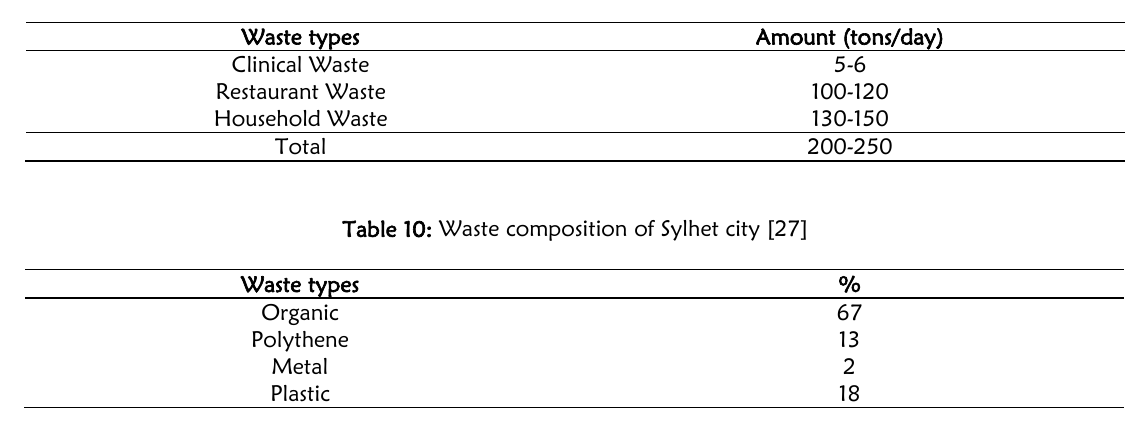
Table 9: Waste generation per day in Sylhet city [27]